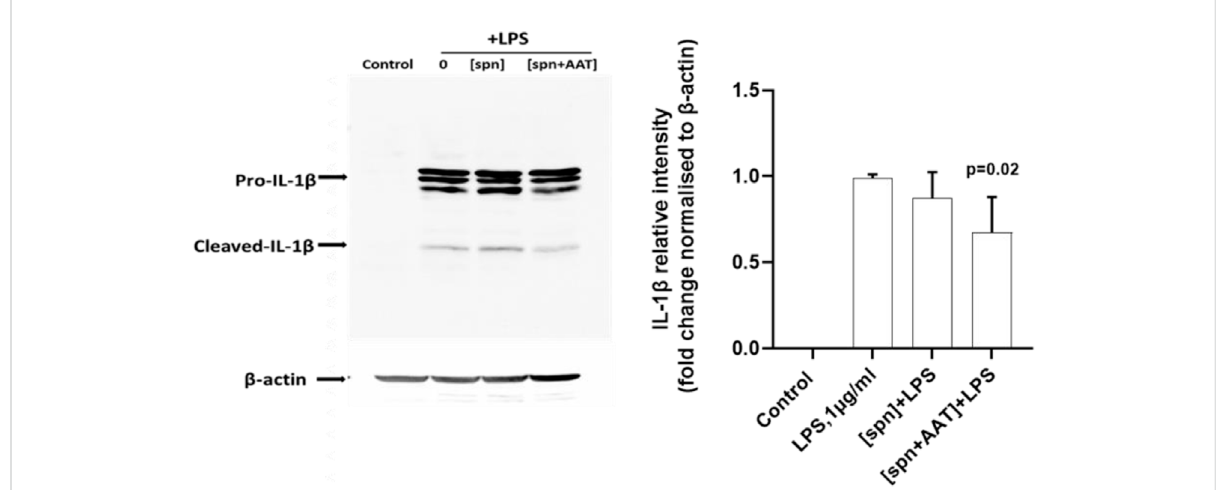
FIGURE 2 Analysis of intracellular IL-1 β in total PBMCs by western blotting shows that supernatants from AAT-pretreated PBMCs [spn + AAT] reduce the accumulation of intracellular pro-IL-1 β . Total PBMCs were stimulated with LPS (1 μ g/ml) in a regular medium or in supernatants from autologous PBMCs pre-incubated alone [spn] or with 4 mg/ml AAT (Zemaira ® ) [spn + AAT] for 30 min at 37 ° C, 5% CO 2 , and fi ltrated through 3 kDa centrifugal fi lters. Fold changes were calculated for each band using the ratio relative to β -actin (loading control), then normalized by the experimental control (LPS-stimulated cells). A representative blot is shown out of four independent experiments. p -value shows a signi fi cant difference between LPS and [spn +